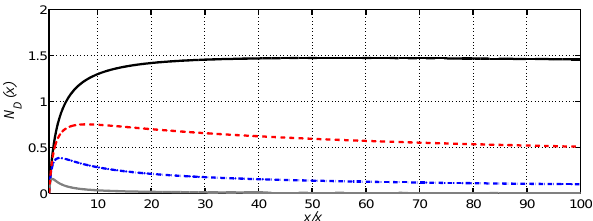
Fig. 13. Wave amplitude variations versus distance (Eq. 53) for γ =1 (black solid line), γ = 4 / 3 (red dashed line), γ = 2 (blue dash- dotted line), γ = 4 (green dotted